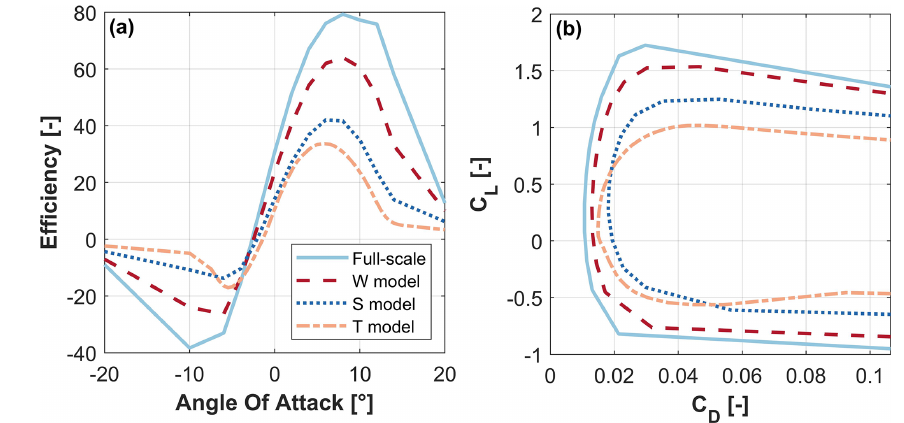
Figure 1. Aerodynamic characteristics of the airfoil at the outermost part of the blades at the corresponding Reynolds number. The full-scale, W, and S models are equipped with the FFA-W3-241 airfoil. The T model is designed with the RG14 airfoil. (a) Efficiency, E = C L /C D , vs. angle of attack; (b) polar curves, i.e., C L vs. C D .